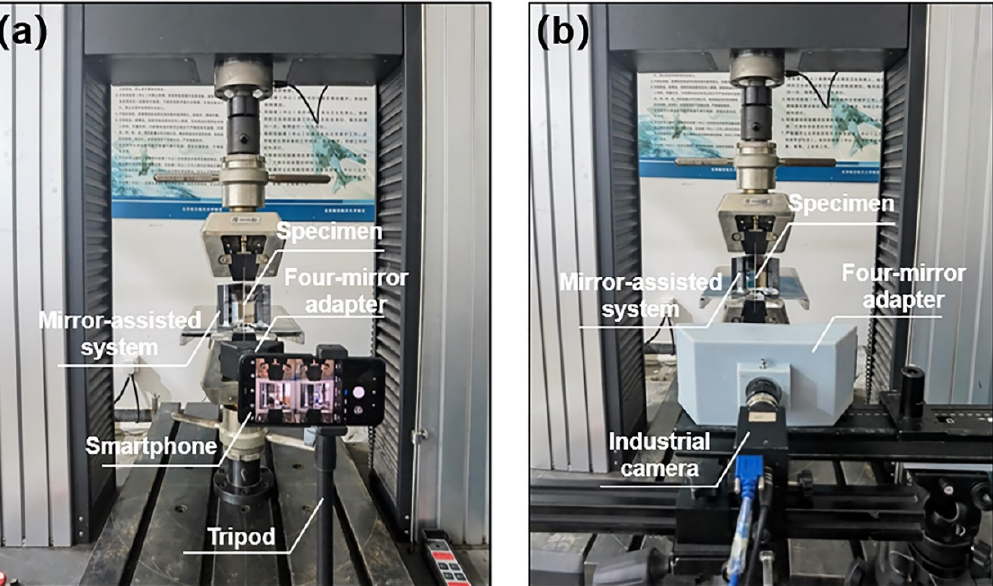
Figure 9. Experiment setup of the uniaxial tensile of aluminum sheet specimens using: ( a ) the smartphone-based system and ( b ) the industrial-camera-based system.